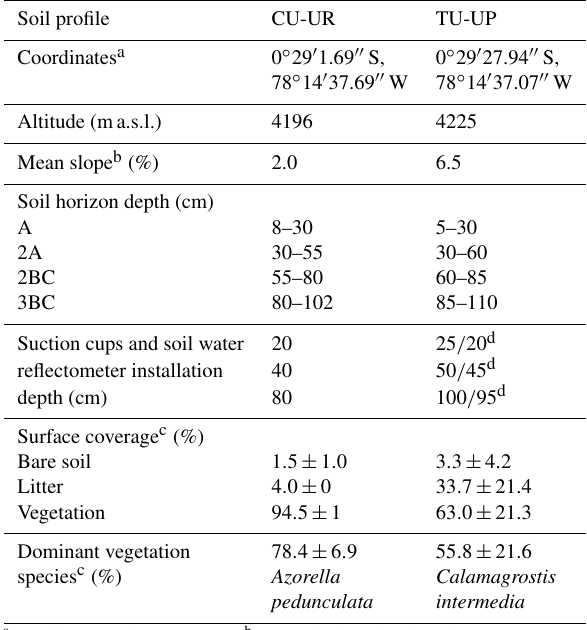
a Coordinates are shown as WGS84. b Mean value, based on three clinometer measurements (Eyeskey Optical Instrument Co., Ltd, China). c Mean value ± 1 standard deviation. d Installation depth of the suction cup and soil water reflectometer,